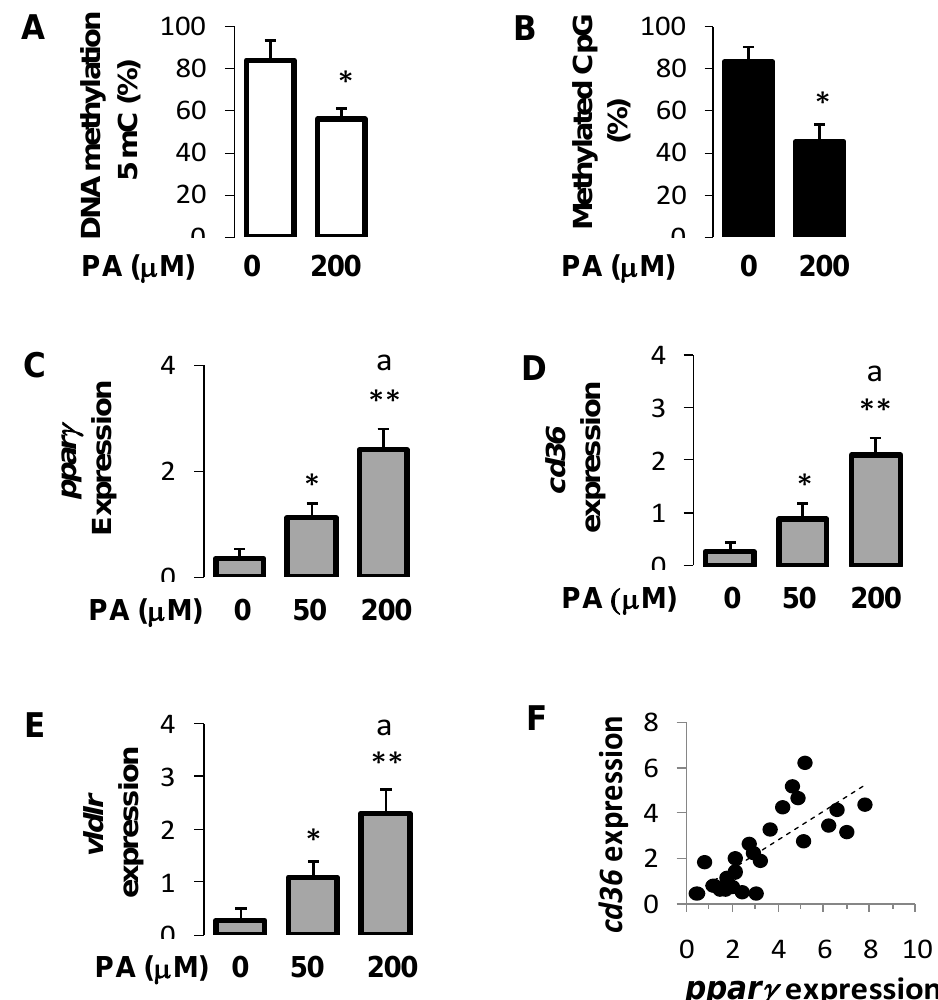
Figure 5. Effects of palmitic acid DNA methylation and gene expression in hepatocytes. Global DNA methylation( A ); ppar γ promoter CpG site methylation ( B ); expression of ppar γ ( C ), cd36 ( D ), and vldlr ( E ); and correlation between ppar γ and cd36 expression ( F ). Primary hepatocytes isolated from six mice were incubated with BSA without palmitic acid (control) or with palmitic acid (50 and 200 µ M) for 24 h. The levels of mRNA was assessed with qPCR ( n = 12 per condition). Data were generated from three independent experiments in which each experimental condition was carried out in duplicates. Data are mean ± SEM. Statistical analysis was performed with ANOVA test followed by Tukey’s test. Significance between palmitic treated and control (untreated, PA 0 µ M) is represented with asterisks, * p < 0.01 and ** p < 0.001, and between 50 and 200 µ M, a p <